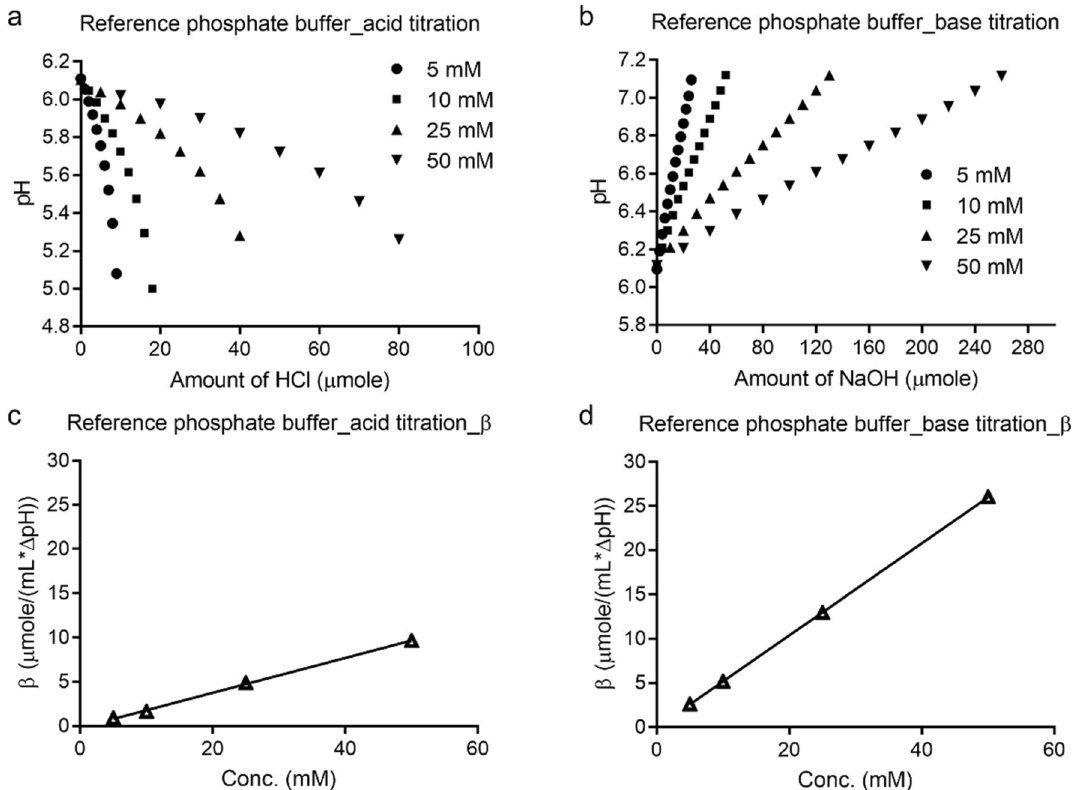
Figure 2. Acid or base titration curves and buffering capacity of reference phosphate buffers at different